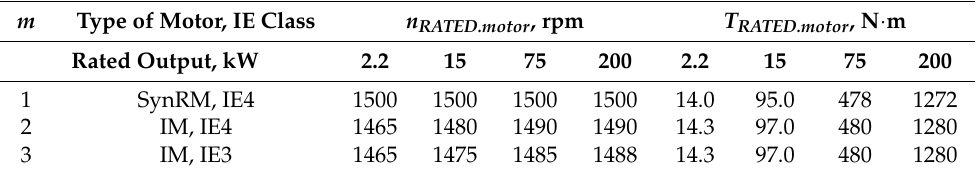
Table 3. Catalogue data of